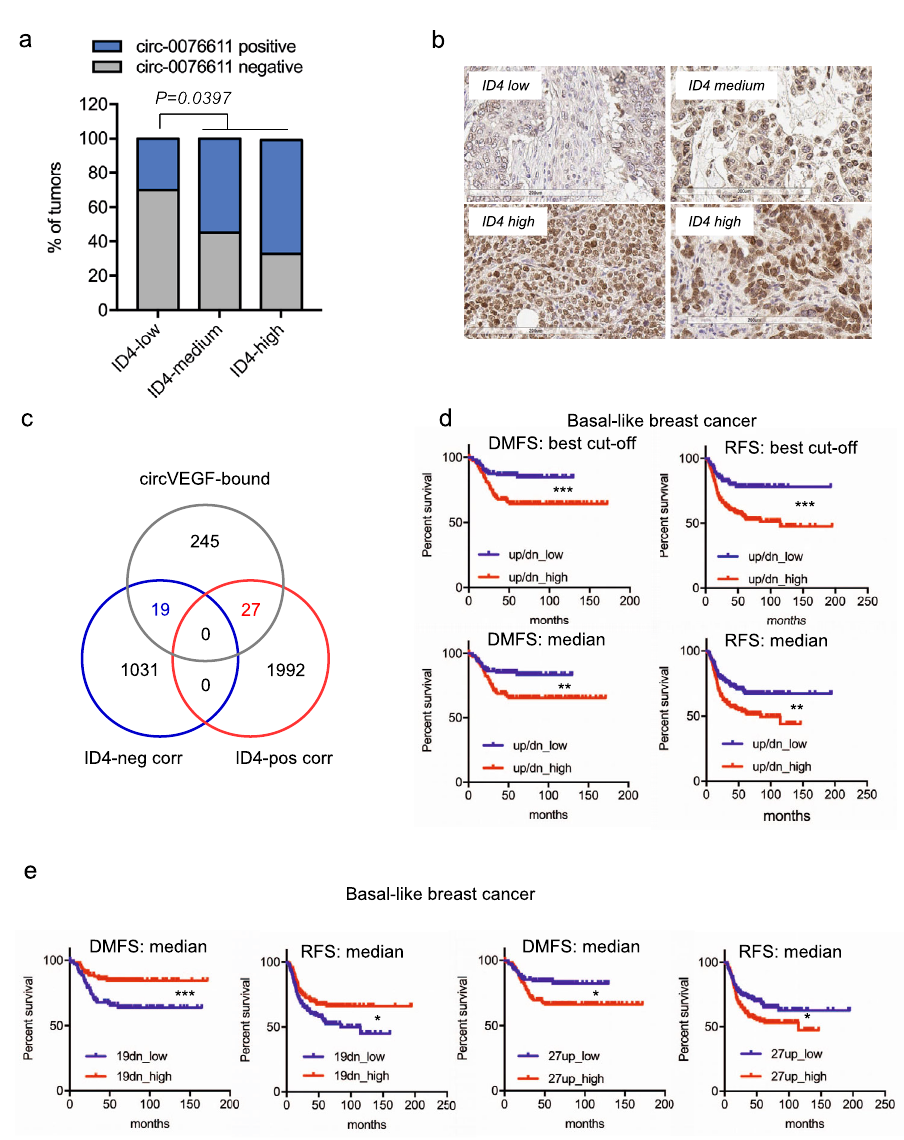
Fig. 8 Circ_0076611 and ID4 protein expression are associated in triple-negative breast cancer. a , b Distribution of circ_0076611 expression in tumors from the TMA (Ck5 + ) characterized by different strength of ID4 protein expression. Two-tailed p value has been calculated by Chi-square test comparing circ_0076611-negative vs. circ_0076611-positive cases, in the two groups with ID4-low vs. ID4-medium/high. Representative images of various ID4 staining intensities, as assessed by immunohistochemistry (IHC), are shown in b . c Venn diagram indicating the intersection between circ_0076611 target mRNAs and transcripts positively or negatively correlated to ID4 in the TCGA basal-like breast cancer dataset. 19-negatively and 27-positively ID4- correlated genes that are also bound by circ_0076611 were identi fi ed. d Kaplan – Meier analysis showing the association between the expression of the two combined signatures of 19-negatively (19dn) and 27-positively (27up) ID4-correlated genes identi fi ed in c and survival [distant-metastasis free survival, DMFS ( N = 275); recurrence-free survival, RFS ( N = 417)] in BLBC patients. Survival analyses were performed using the KMplot database (www.kmplot. com) considering the mean expression of the selected genes. Evaluation of combined signatures (up/dn) has been performed by setting the 19dn signature as “ inverted ” in the KM plotter. “ Best cutoff ” setting was used to split patients. Asterisks refer to logrank p (** p < 0.005, *** p < 0.0005). e Kaplan – Meier analysis showing the association between the expression of the two groups of 19-negatively (19dn) and 27-positively (27up) ID4-correlated genes identi fi ed in c and survival [distant-metastasis free survival, DMFS ( N = 275); recurrence-free survival, RFS ( N = 417)] in BLBC patients. Survival analyses were performed using the KMplot database (www.kmplot.com) considering the mean expression of the selected genes and using the median value to split the patients. Asterisks refer to logrank p (* p < 0.05, *** p < carried out on QuantStudio5 Fast Sequence Detection Systems (Applied Biosys- tems, Carlsbad, CA, USA). For real-time PCR analysis of circ_0076611 in serum samples from BC patients and in RIP/ChIRP experiments, a linear preampli fi cation of circ_0076611 using oligonucleotides divF and divR (Supplementary Data 1) and AmpliTaq Gold ™ 360 Master Mix was performed, and, subsequently, 1µl of this reaction was used to perform real-time PCR with TaqMan assay as above descri- bed. All primers and TaqMan probe were purchased from IdT (Integrated DNA Technologies) if not speci fi ed differently. Supplementary Data 1 includes the various primers used in PCR.